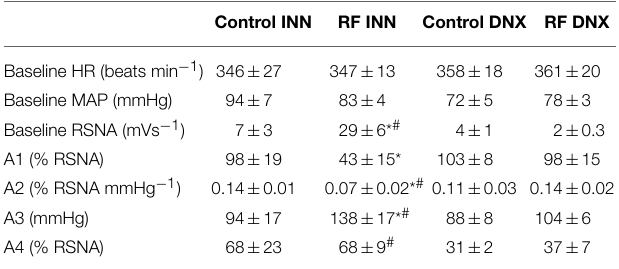
Frontiers in Physiology |